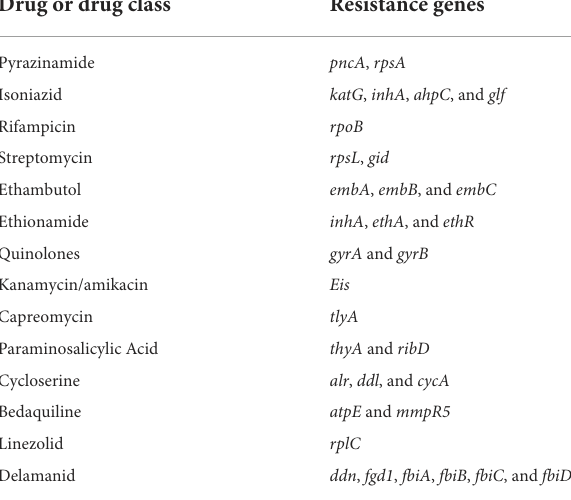
TABLE 2 Resistance genes in Mycobacterium tuberculosis variant bovis strains isolated in Mato Grosso associated with antibiotics routinely used in the treatment of human